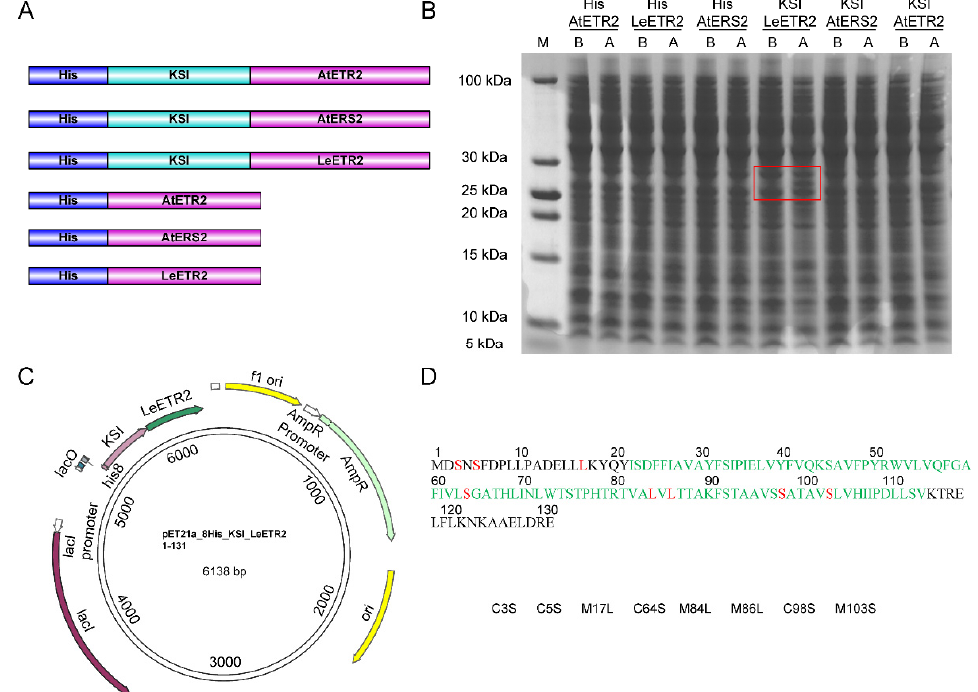
Figure 1. The construct design and expression of ethylene receptors. ( A ) The His8-tagged KSI constructs and His8-tagged constructs of ETR2 or ERS2. For each protein construct, different colors represent different domains: His8 tag (blue), KSI (cyan), protein sequence (pink). ( B ) The screening expression results of 6 constructs. ( C ) One example of the plasmid map of His8-KSI tagged LeETR2 1–131 construct used for expression. ( D ) The amino acid sequences of LeETR2 1–131 and the mutation sites with respect to the purification.